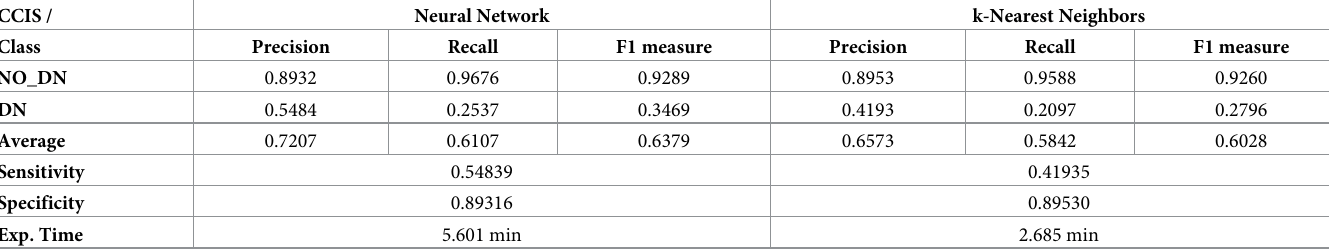
Network more powerful as it performs well in large dataset. On the other hand, k-NN yielded the best accuracy using Under-Sampling technique for ENG dataset and Smote technique for CCIS dataset (0.8636 for ENG and 0.8657 for CCIS). The results are outstanding because the Under-Sampling method reduces the Majority class to reach the minority class’s size which diminishes the dataset size. This boosts the k-Nearest Neighbors classifier’s performance as it operates better in small dataset [15]. For CCIS dataset, this classifier obtained the best results with Smote-Sampling because this technique is based on k-NN to balance the instances throughout the classes (as explained in the methodology section) [26]. After finding the best model achieving the highest accuracy for ENG (using Over with NN and Under with k-NN) and CCIS (using Over with NN and Smote with k-NN) datasets, sev- eral prediction (classification) measures are computed on the testing set to validate the obtained results since it not possible to perform a comparison study with the state of the art works. Tables 9 and 10 show the precision, the recall, and the F1 measure for both classes, as well as the sensitivity, the specificity, and the running time for each classifier using ENG and CCIS datasets. As specified in these tables, the precision, recall, and F1 measure values for NO_DN class using k-NN and NN are more or less than 90% which means that most of the instances belonging to that class are correctly predicted. However, for the DN class, these measures reach a value between 21% and 58% which signifies that not all the instances belonging to the DN class are correctly classified but the result remains acceptable. Moreover, the specificity values given by both classification algorithms for both datasets signify that both proposed models successfully identify the students with NO_DN case. However, the sensitivity values determine that the models can eventually detect the students with the DN case (with an aver- age of 40%). Concerning the experiment time, the k-NN is faster than the NN due to the structure of the classifier and the fact that NN requires large dataset contrary to k-NN. Conse- quently, the absences can be predicted using the GPA, the number of courses, the average number of lectures per day, and the average number of breaks per day. Table 10. The prediction results obtained using both classifiers for CCIS dataset. CCIS